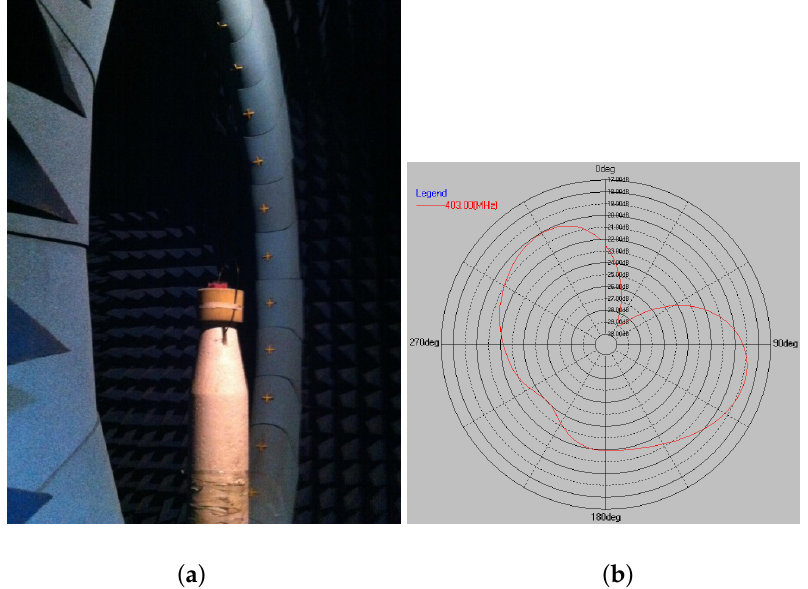
Figure 12. ( a ) The measurement setup inside an anechoic chamber, and ( b ) the horizontal radia- tion